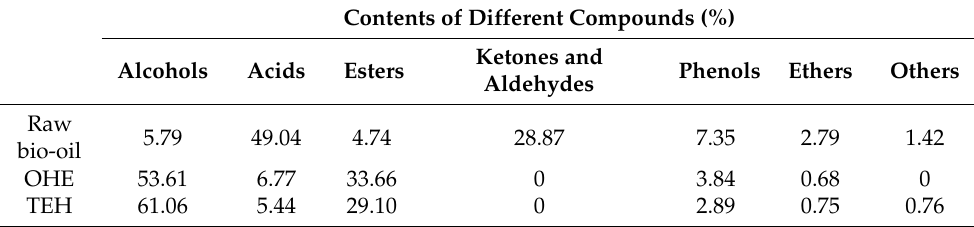
Table 5. The product distribution after two methods to upgrade bio-oil over Mo-Raney Ni catalyst. Contents of Different Compounds (%) Alcohols